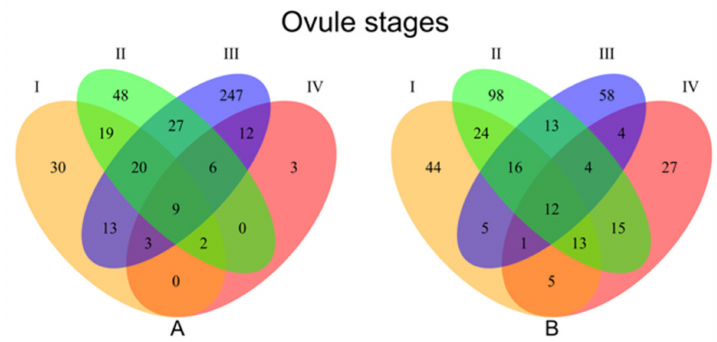
Figure 2. Venn diagrams showing number of di ff erentially expressed transcripts between apomictic and sexual genotypes at each ovule developmental stage. A: Genes downregulated in the 6x apomicts compared to 2x sexuals B: Genes upregulated in the 6x apomicts compared to 2x sexuals. I = premeiotic, II = meiotic / aposporous, III = early embryo sac, IV = mature embryo